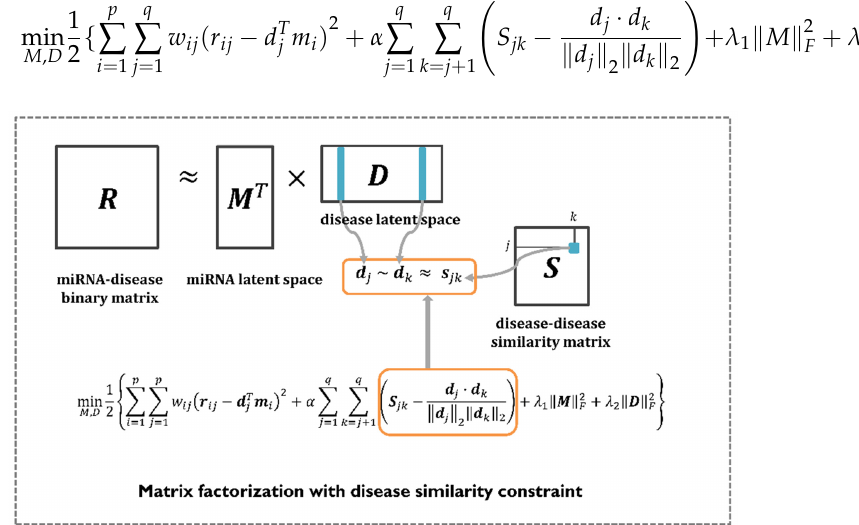
Figure 2. The workflow of MDMF. MDMF learns the two latent spaces whose products are close to the observed entries in the original matrix, whereas the cosine similarity of the disease latent space is close to the value of the integrated disease similarity matrix.